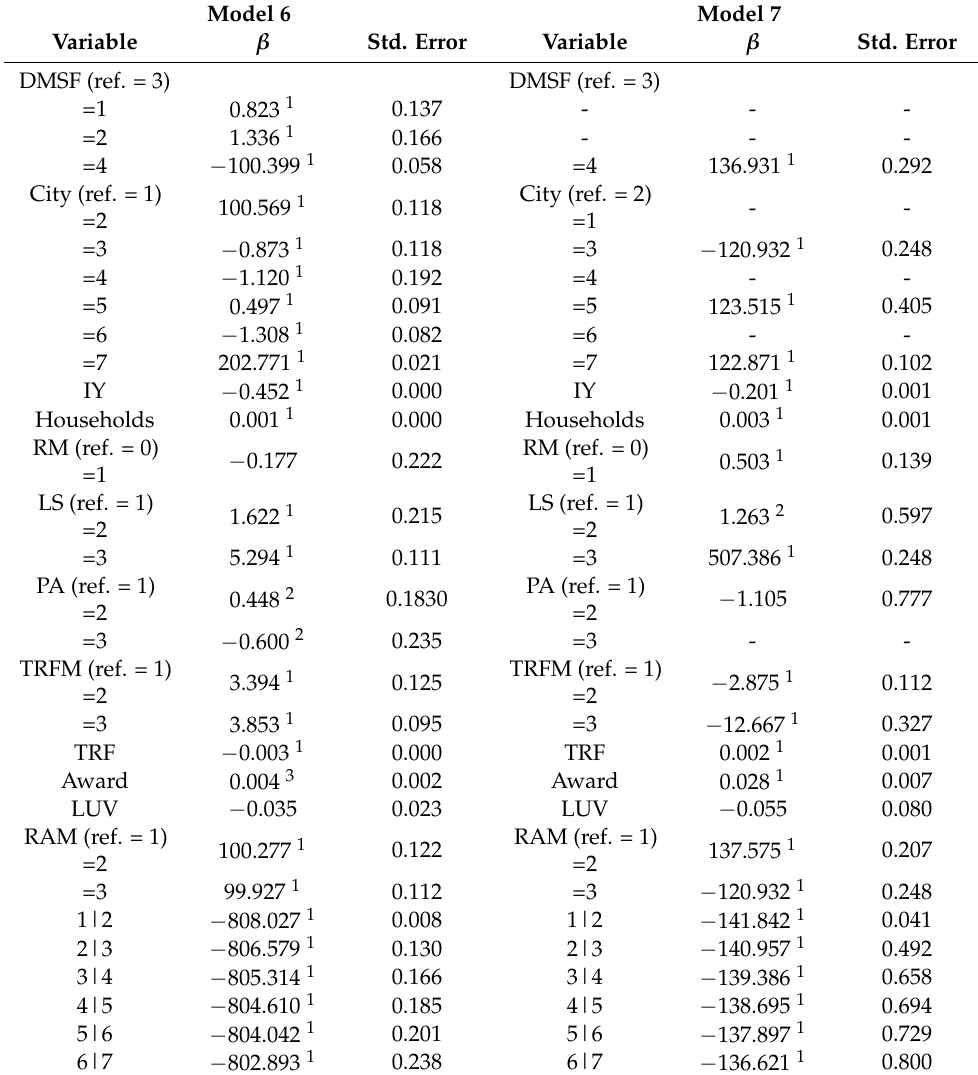
Table 7. Results of multinomial ordered logit estimates for testing Hypothesis